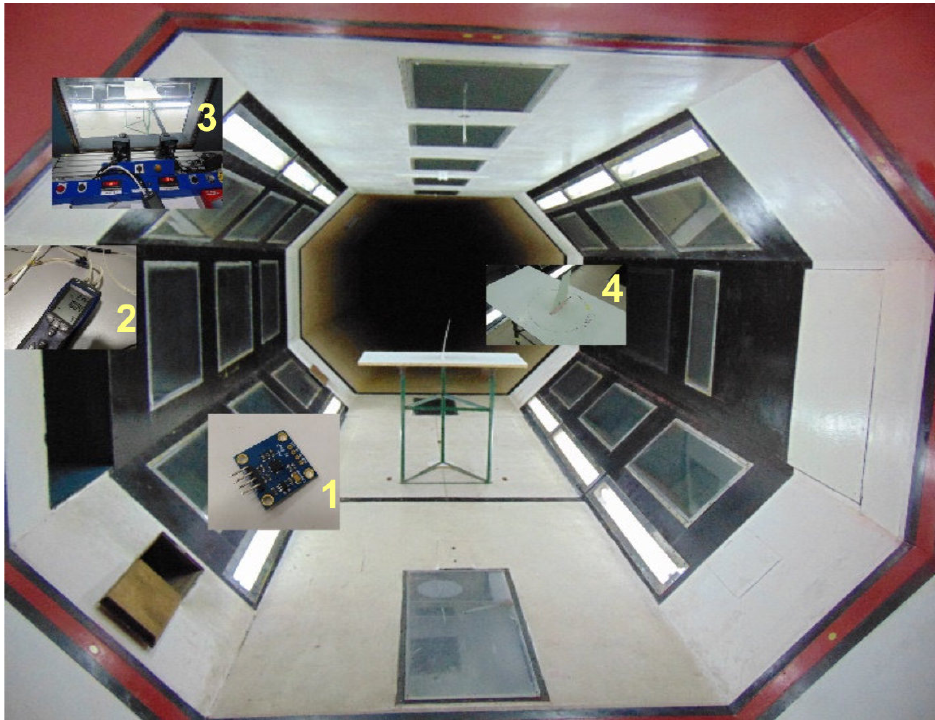
Figure 15. Wind tunnel flutter test setup, 1) Accelerometer (sensor), 2) PCE PFM2 micro manometer with Pitot tube, 3) High- Speed camera(s), 4) Fin testing fixture clamp Table 4. Flutter velocity comparative results